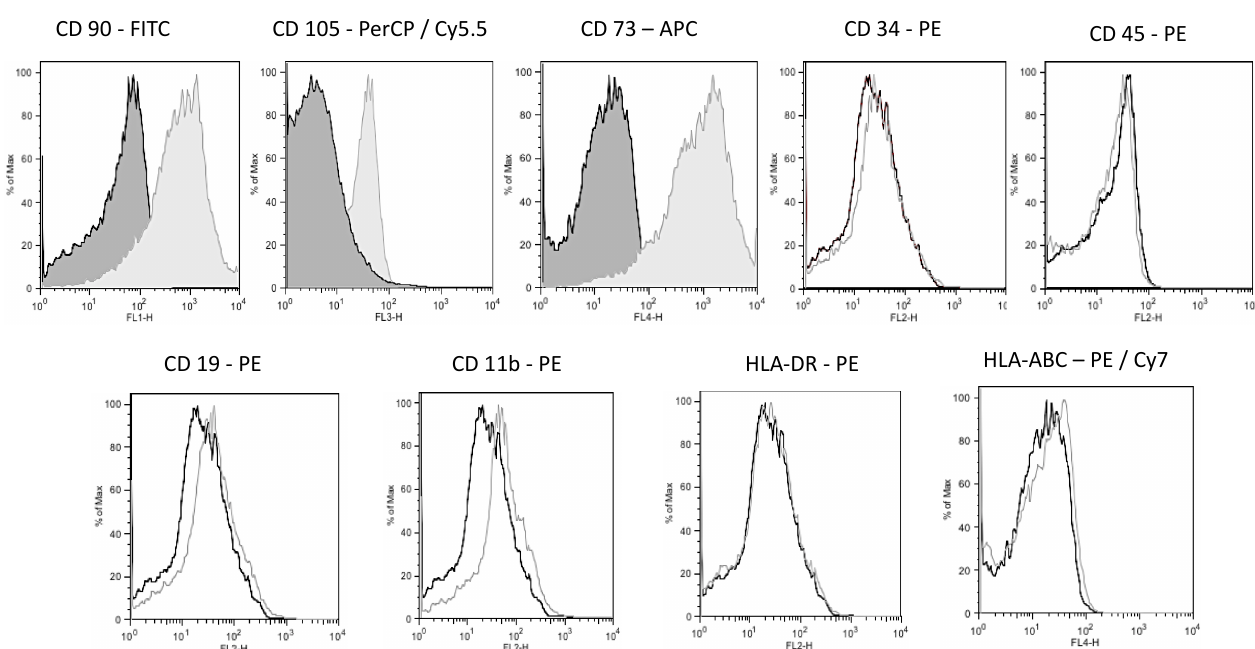
Figure 9. Flow cytometry histograms of hWJ-MSCs. Flow cytometry revealed that hWJ-MSCs at passage 3 were strong positive for mesenchymal markers CD73, CD90, CD105, negative for hematopoietic stem cell markers CD34, CD45, CD11b, CD19, and human leukocyte antigens HLA-DR and HLA-ABC in agreement with International Society for Cellular Therapy (ISCT) established minimal criteria for MSC culture characteristics.